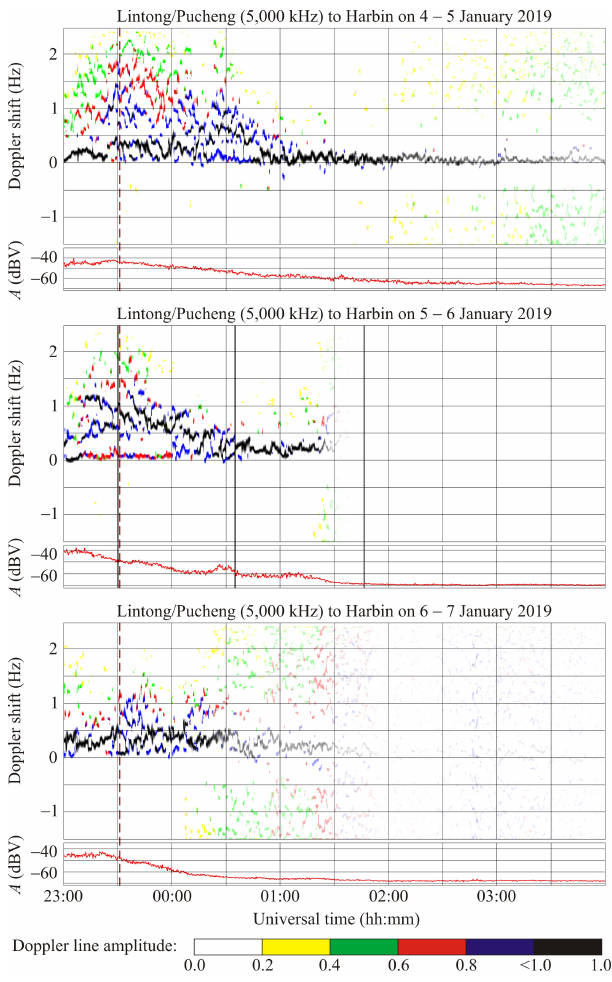
Figure 5. The same as in Fig. 4 but for the Chiba/Nagara to Harbin radio-wave propagation